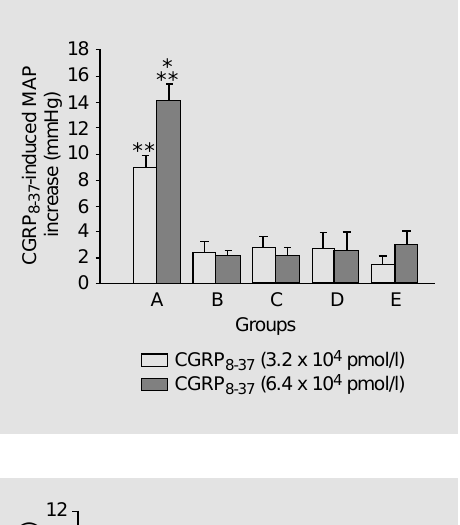
0Figure 3. The calcitonin gene- related peptide receptor antago- nist CGRP 8-37 increases mean arterial pressure (MAP) in the N (cid:2) -nitro-L-arginine methyl ester (L-NAME)-treated pregnant rats. Animals were instrumented for continuous MAP recording and CGRP 8-37 administration on days 19, 20, and 21 (D19-21) of pregnancy and postpartum day 1 (P1). With the animals in a fully awake and unrestrained state, bolus doses of 100 µg CGRP 8-37 were given. *P<0.05 compared to control animals (ANOVA followed by the Tukey- Kramer multiple comparisons